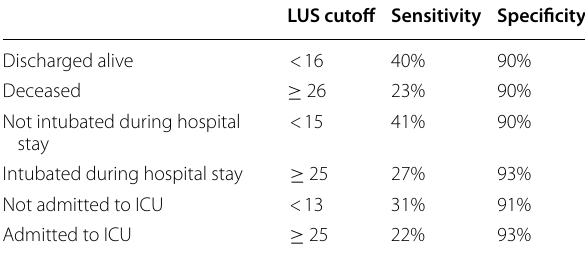
Table 3 LUS and outcome cutoffs LUS cutoff Sensitivity